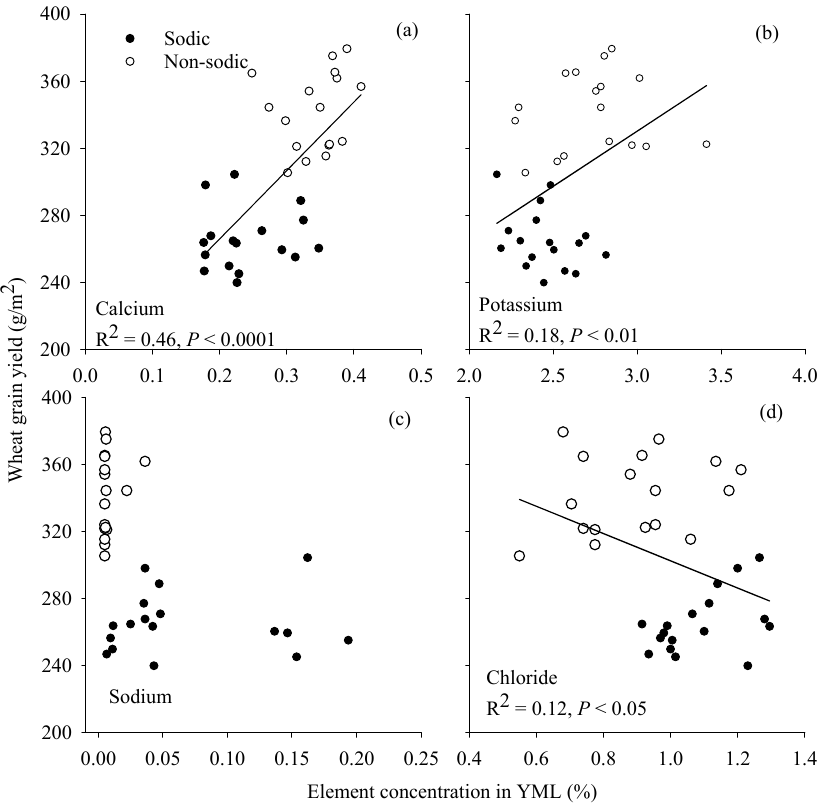
Figure 6. Relationships between grain yield of wheat genotypes element concentrations of ( a ) calcium, ( b ) potassium, ( c ) sodium, and ( d ) chloride in young mature leaves of barley genotypes grown on a sodic site and a non ‐ sodic site at Goondiwindi in southern Queensland in 2008.